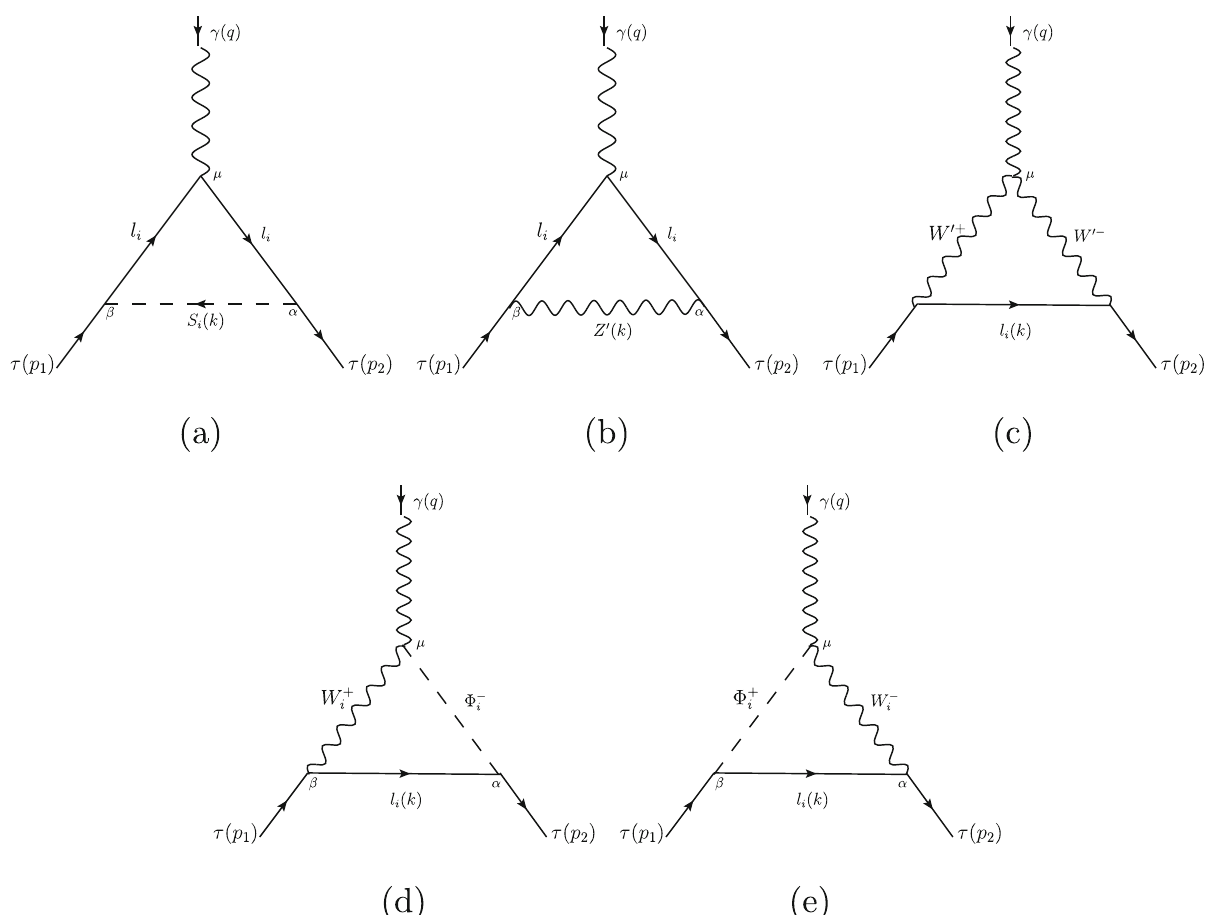
Fig. 1 Generic Feynman diagrams that contribute to the AMDM of the tau-lepton, l i ≡ τ,ν τ . a Scalar contributions, S i ≡ σ, A 0 , H 0 ,η 0 ,φ 0 . b , c Vector contributions, V i ≡ Z (cid:2) , W (cid:2)± . d , e Scalar–vector contributions, W ±